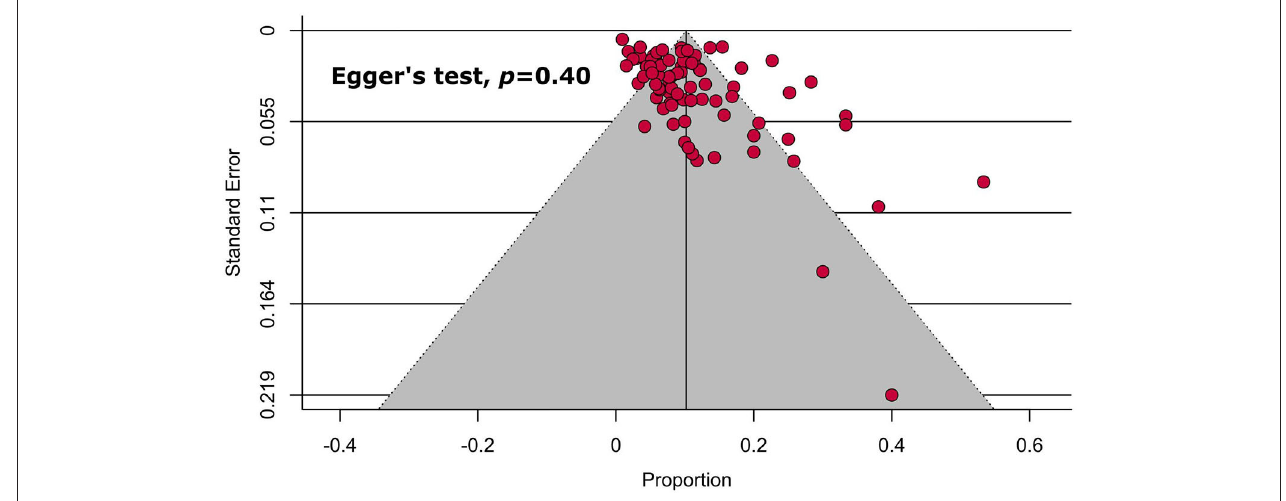
FIGURE 4 | Funnel plot on the prevalence of headache in COVID-19 patients.